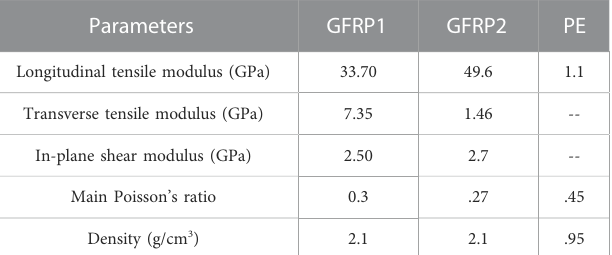
TABLE 2 Parameters of